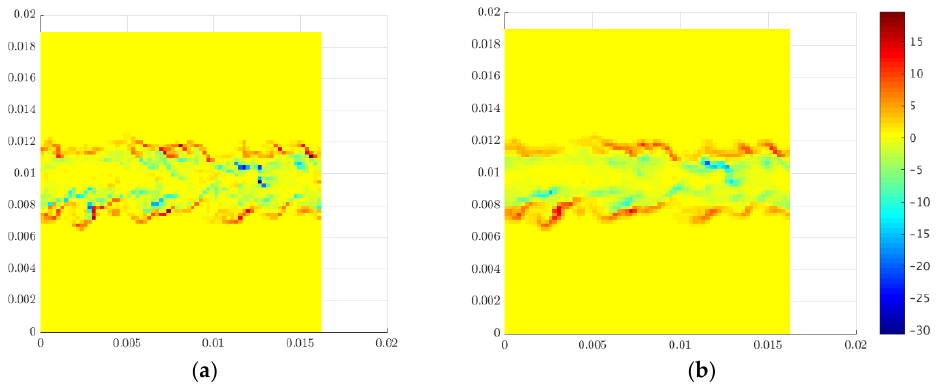
Figure 11. Residual 𝜔̇ 𝐻2𝑂 with units (kg/(m 3 s)) when DNS is filtered by using ∆/∆ DNS = 12 at 𝑡 = 20𝑡 𝑗 : ( a ) Exact; and ( b ) Predicted by Model A. Cut-off plane is the central xy plane.